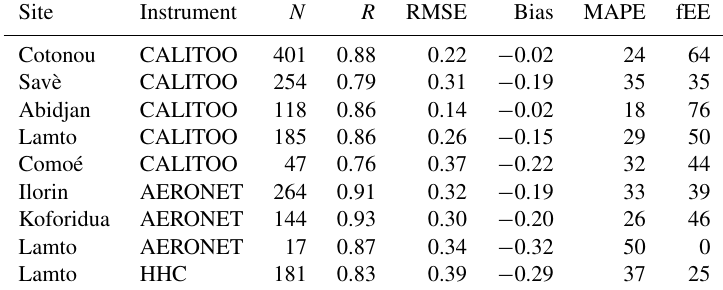
Table 2. Results of the MODIS and sun photometer AOD comparison by site location and type of instrument, indicating the number of data (N) , Pearson correlation coefficient (R) , root mean square error (RMSE), bias, mean absolute percentage error (MAPE) and fraction falling within the MODIS expected error (fEE).